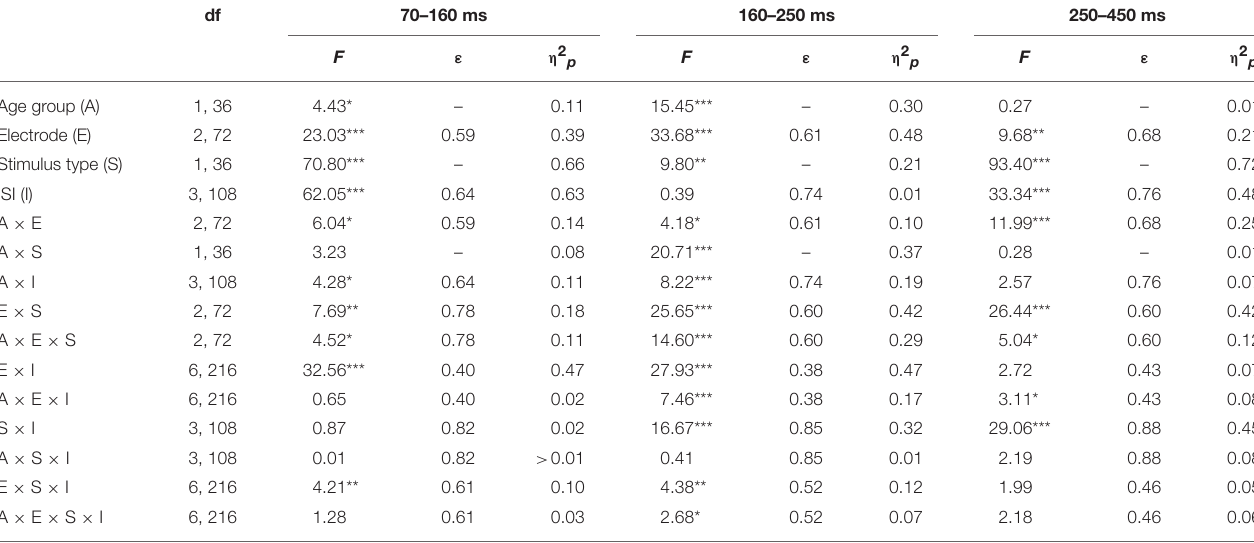
TABLE 2 | Statistical evaluation of the group effect (19–39 vs. 55–78 years) and the effects of the repeated-measure factors Stimulus type (standard vs. novel), ISI (10, 5, 3, or 0.5-s ISI condition), and Channel (Fz, Cz, or Pz) of the average ERP amplitude within the 70–160ms, the 160–250ms, and the 250–450ms time window by means of separate analyses of variance (ANOVA).